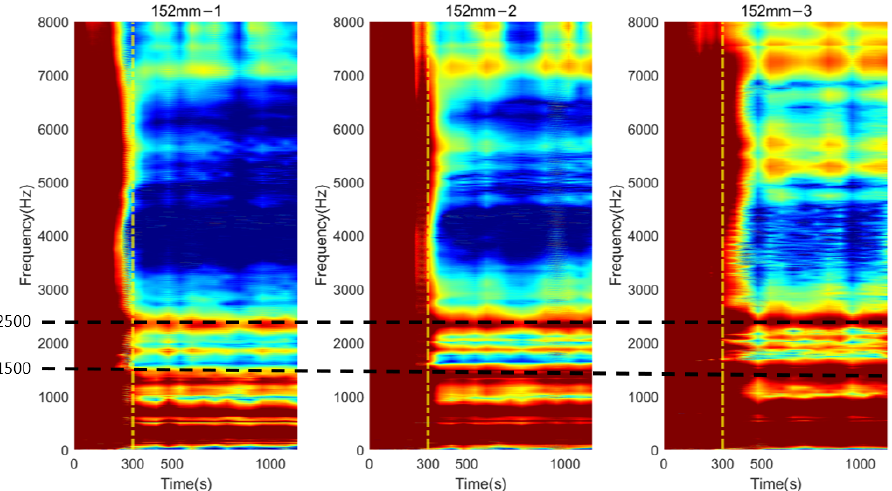
Figure 11. Colormap of the normalised magnitude development as a function of cure time for 152 mm.